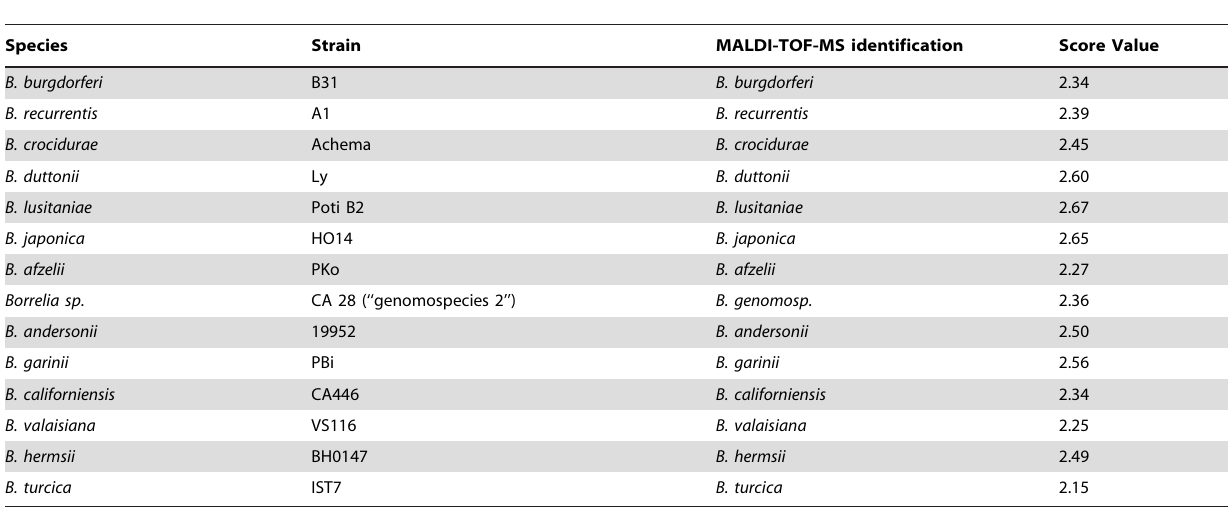
Table 1. Borrelia species used to establish a MALDI-TOF-MS reference database.